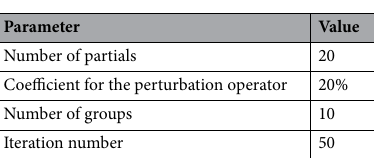
Table 1. Selected parameters of BHO